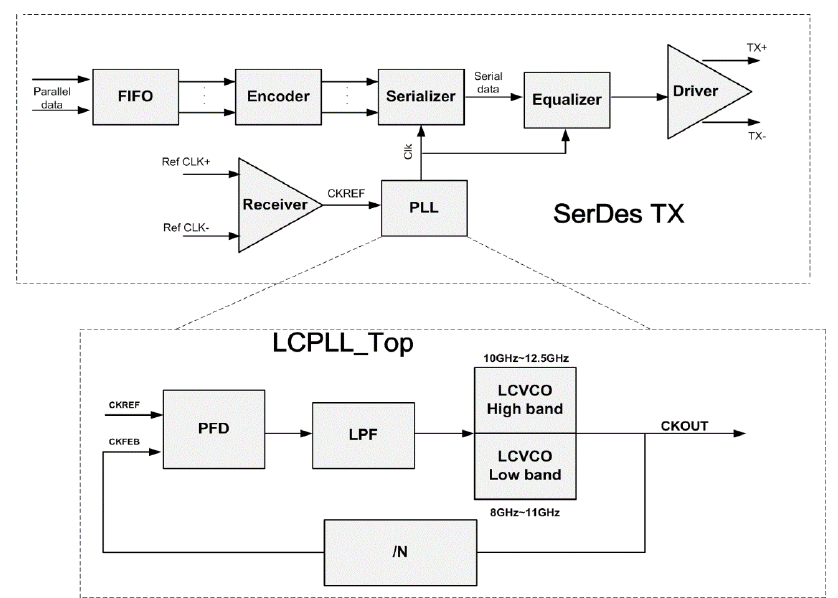
Figure 1. Block diagram of the Serdes transmitter (TX) and the inductance capacitance (LC) phase- locked loop (PLL) structure. FIFO: first-in first-out; PFD: phase and frequency detector; LPF: low pass